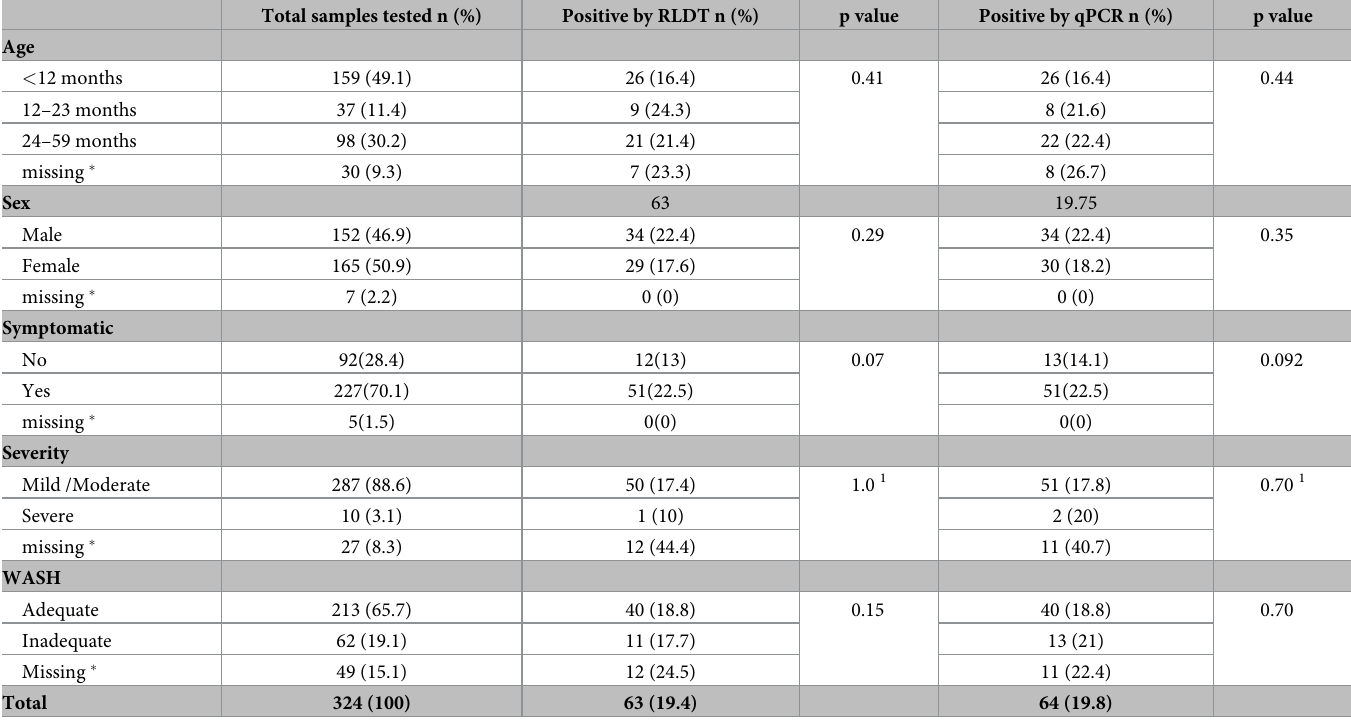
Table 1. Baseline characteristics by qPCR/ RLDT positivity.